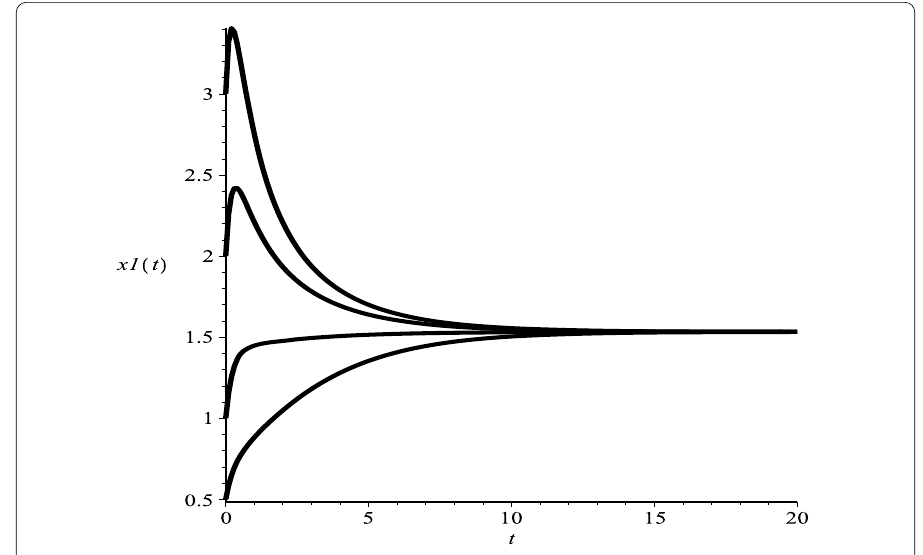
Figure 2 Dynamics behavior of the first component x 1 ( t ) of system (5.1); here we take k = 0.9 and the initial conditions ( x